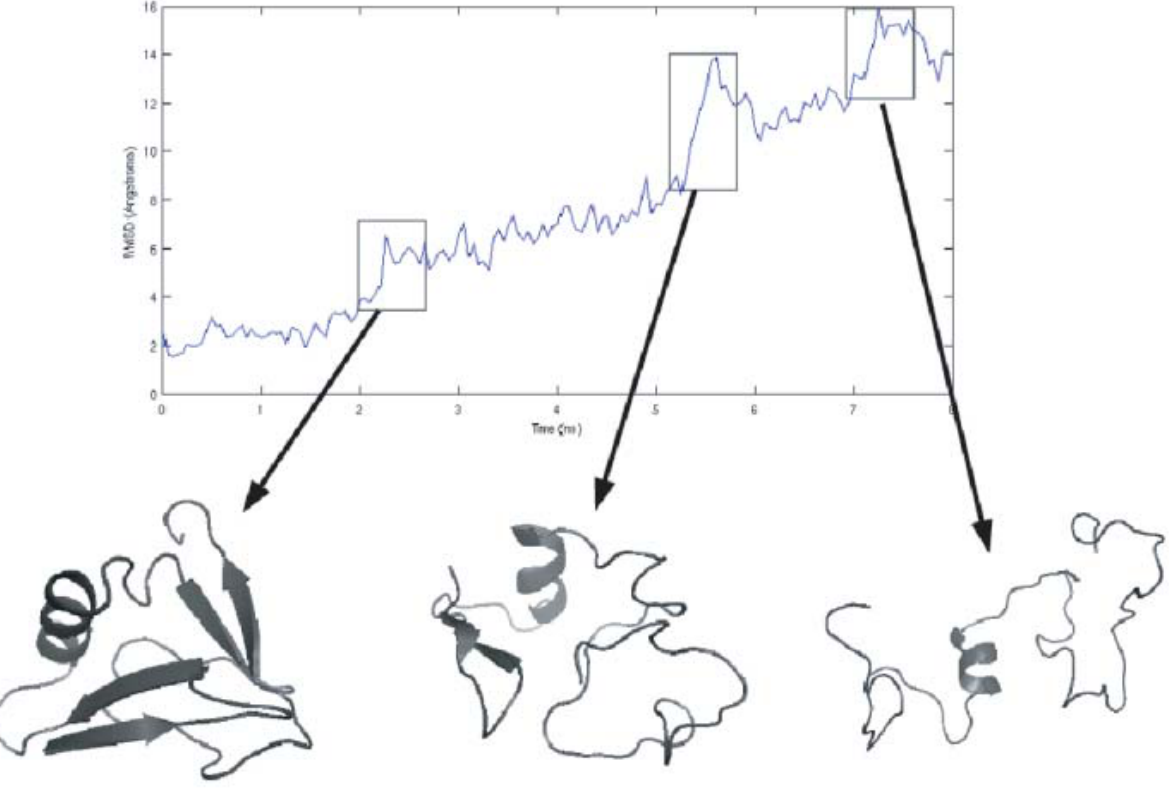
Figure 3. The plot shows the evolution of the RMSD of the backbone C_ atoms from the energy minimized structure of ubiquitin. Three critical phases are discernible. The first phase at < 2.5 ns involves the breaking of the b 1 – b 5 interaction. The second phase occurs at < 5.5 ns and involves the breaking up of the b 3 – b 4 hairpin along with the associated secondary structure. The third phase occurs at < 7 ns and involves the breaking up of the b 1 – b 2